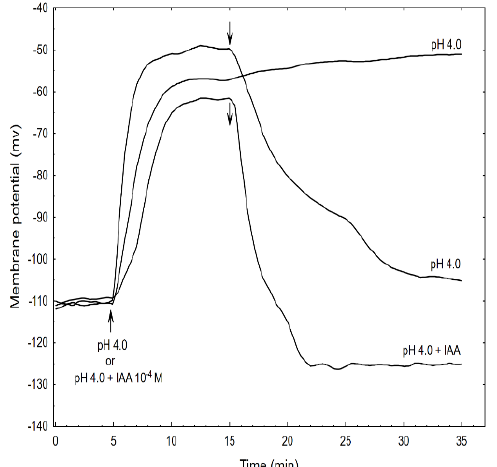
Figure 7. Effect of the acid buffer (pH 4) and its combination with the IAA on the membrane potential (E m ) of the parenchymal coleoptile cells. At time 5 min (arrow), the control medium was changed for a new one with the same salt composition, but that also contained the acid buffer (pH) or its combination with the IAA (10 − 4 M). An arrow pointing down indicates the exchange of the medium for the control medium. The representative curves for each variant are shown. The adequate mean values are indicated in the text.